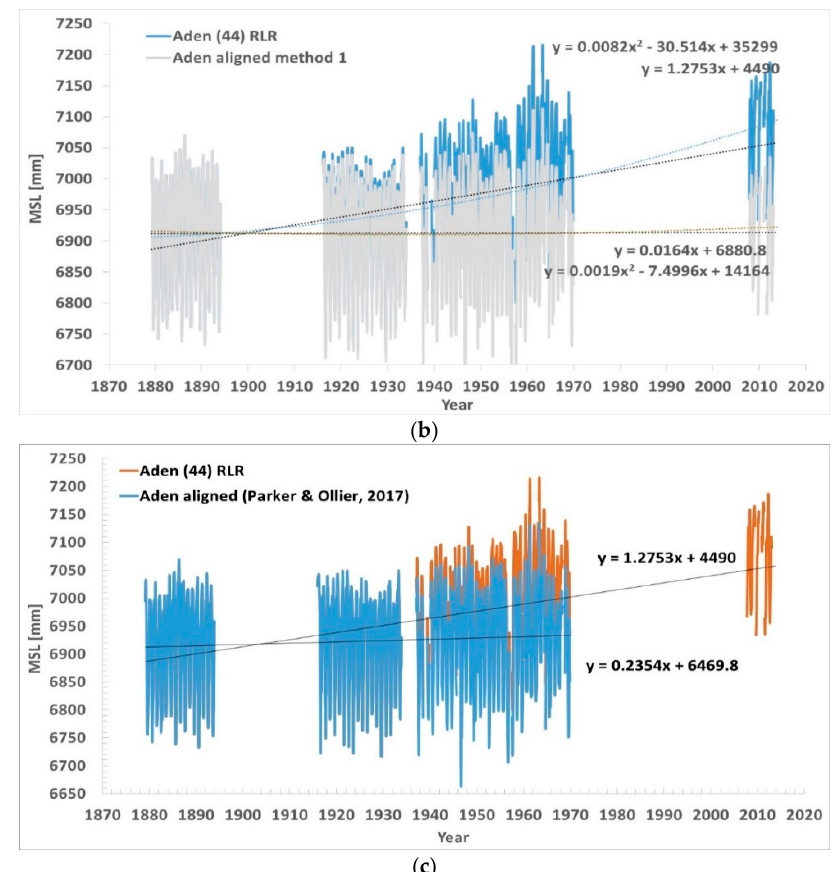
Figure 5. Aden results. ( a ) Linear fittings applied to the five segments. ( b ) MSL aligned compared to the PSMSL RLR data. ( c ) MSL aligned, with the same method, but only three segments, as in [21], with the latest data omitted, compared to the PSMSL RLR data. When measured, the sea levels are rising slowly, or they are decreasing. The rising trend of the PSMSL RLR data is the result of the shifts of one segment versus the other, always upwards versus the values suggested by the alignment of the breakpoints.